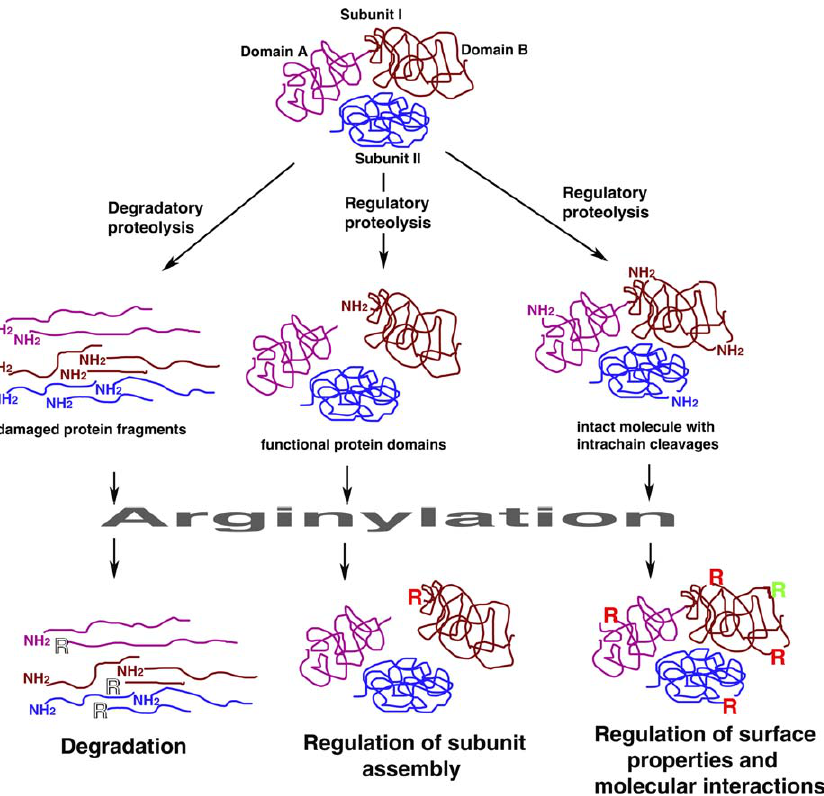
Figure 7. Protein Regulation by Arginylation Top: schematic representation of a protein containing two subunits (I, magenta and brown, and II, blue), whose subunit I is divided into two structurally and functionally distinct subdomains (A and B) within the same polypeptide chain. Middle: proteolytic products of this protein produced by degradation (left), interdomain cleavage (middle), or hypothetical intrachain proteolysis that occurs without the loss of the tertiary structure (right). Bottom: arginylation of the N-termini exposed during these proteolytic events could either produce denatured arginylated peptides (left), modulate the surface properties of active protein fragments (middle), or modulate the surface properties of the intact molecule (right). The last case also includes side chain arginylation, where Arg could be added onto the side chain of Asp or Glu (or possibly other residues) without proteolytic cleavage. Letters R in different colors indicate Arg residues added onto the damaged protein products (white), functional sites on the surface of proteins or domains (red), or side chains exposed on the protein surface (green).